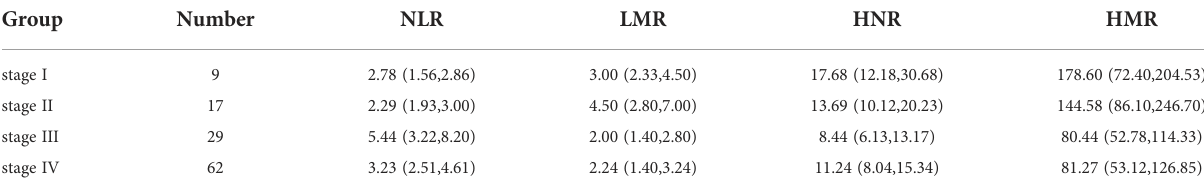
TABLE 2 The expression levels of NLR, LMR, HNR, and HMR in patients of different stages. Group